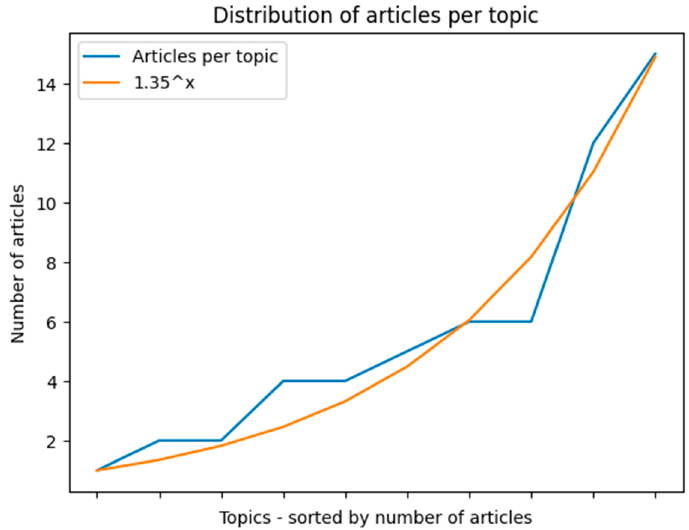
Figure 8. Distribution of articles per topic extracted via LDA.